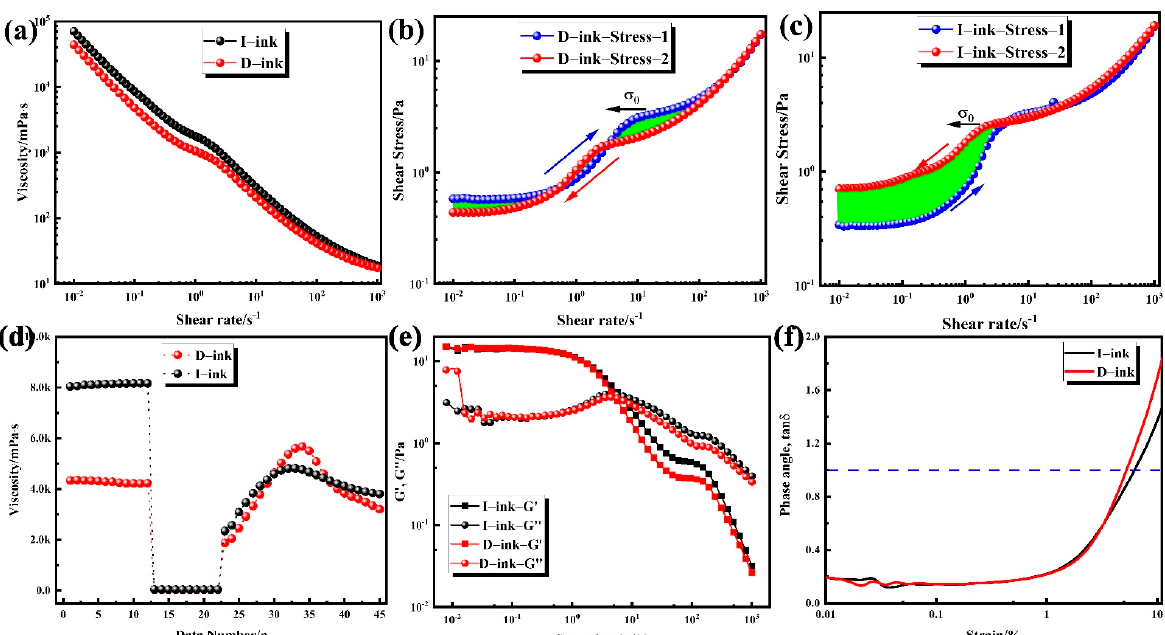
Figure 6. ( a ) Dynamic viscosity data of tested catalyst inks; ( b , c ) shear stress as a function of the shear rate for I-ink and D-ink; ( d ) three interval thixotropy test of catalyst inks, and amplitude oscillation test of the inks; ( e , f ) strain-dependent storage modulus (G ′ ) and loss modulus (G ″ ) at 1 Hz and phase angle.